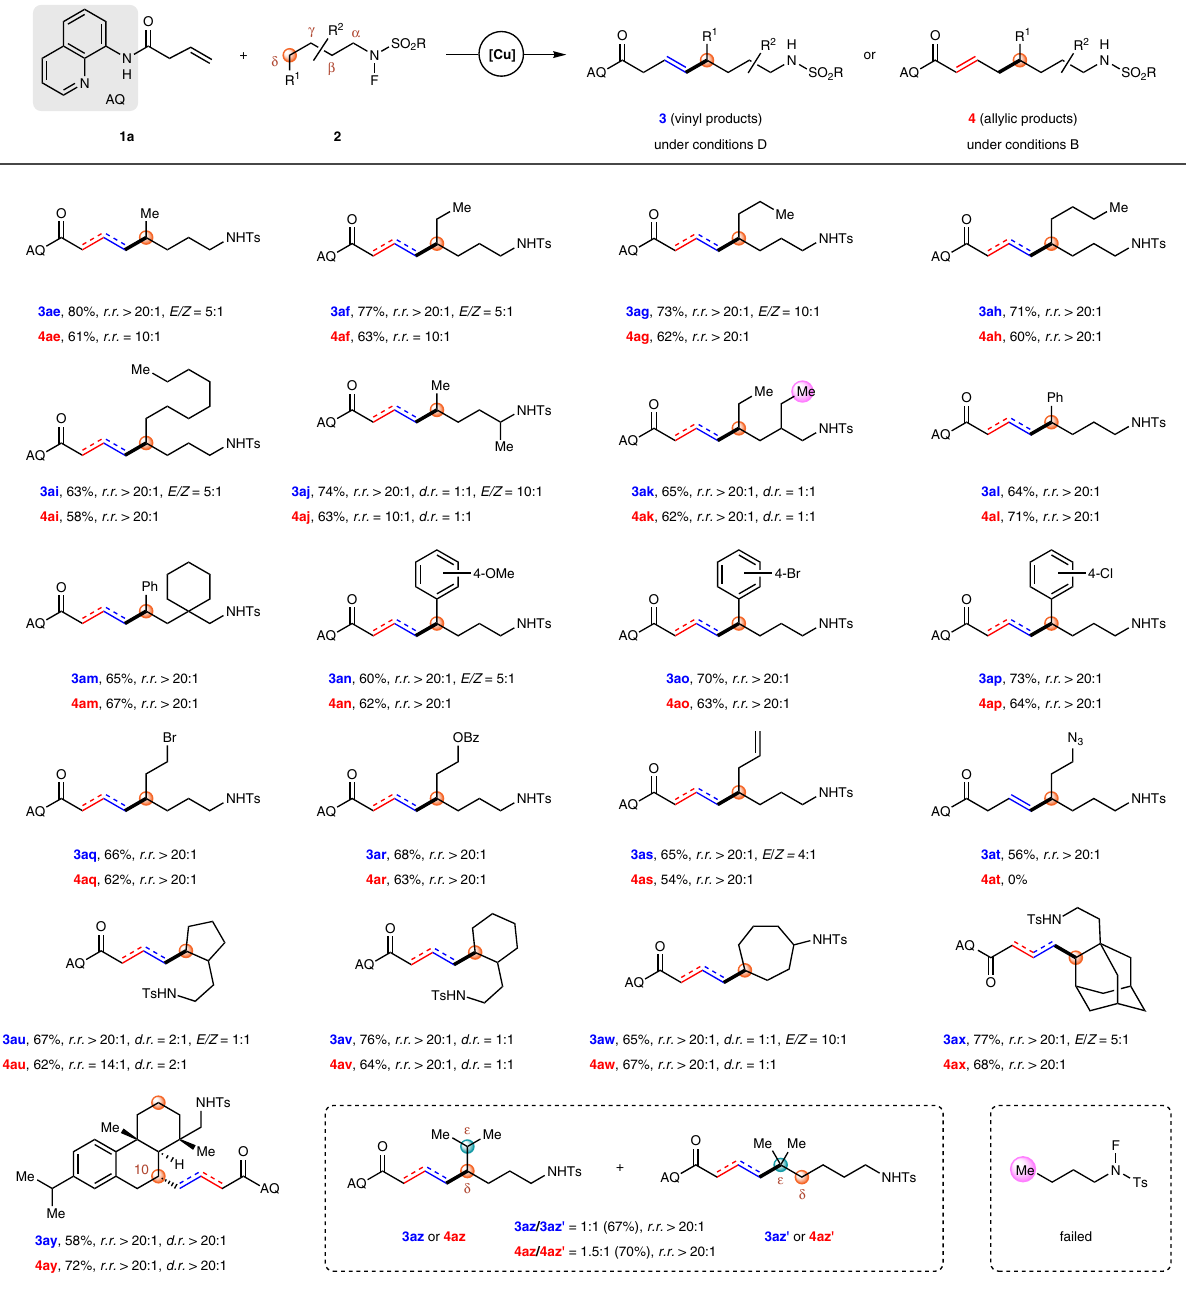
Zn(OAc) 2 (0.08mmol), and TFA (0.40mmol) in benzene (2.0mL) at 90°C for 4h. Isolated yields are shown. E / Z is >20:1 if not stated otherwise. TFA tri fl uoroacetic